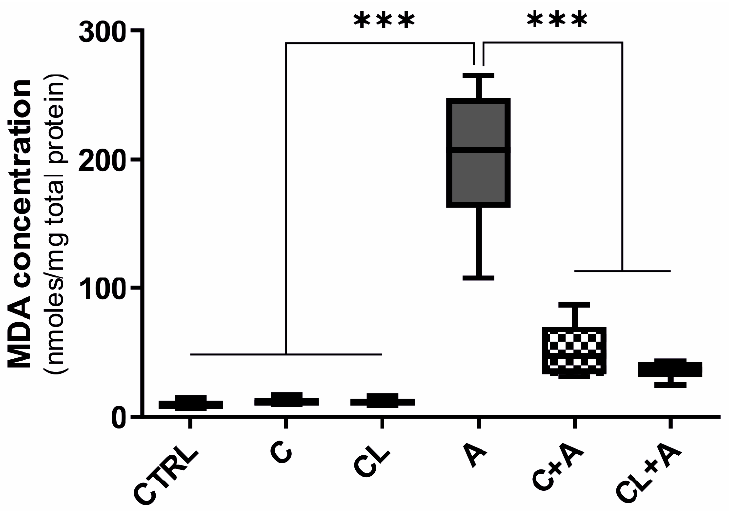
Figure 7. Lipid peroxidation (MDA content). Box and whiskers plot reporting the MDA content in the di ff erent experimental conditions. The median MDA concentration in cells exposed to AFB1 was compared to the MDA concentration observed in all the other experimental conditions. Data are expressed as median concentration and data distribution (i.e., quartiles) of six independent cell culture experiments. CTRL condition corresponds to cells exposed to PCB126 only. C = curcumin; CL = Curcuma longa ; A = AFB1. *** p < 0.001 (one-way ANOVA, followed by Dunnett’s multicomparisons test).